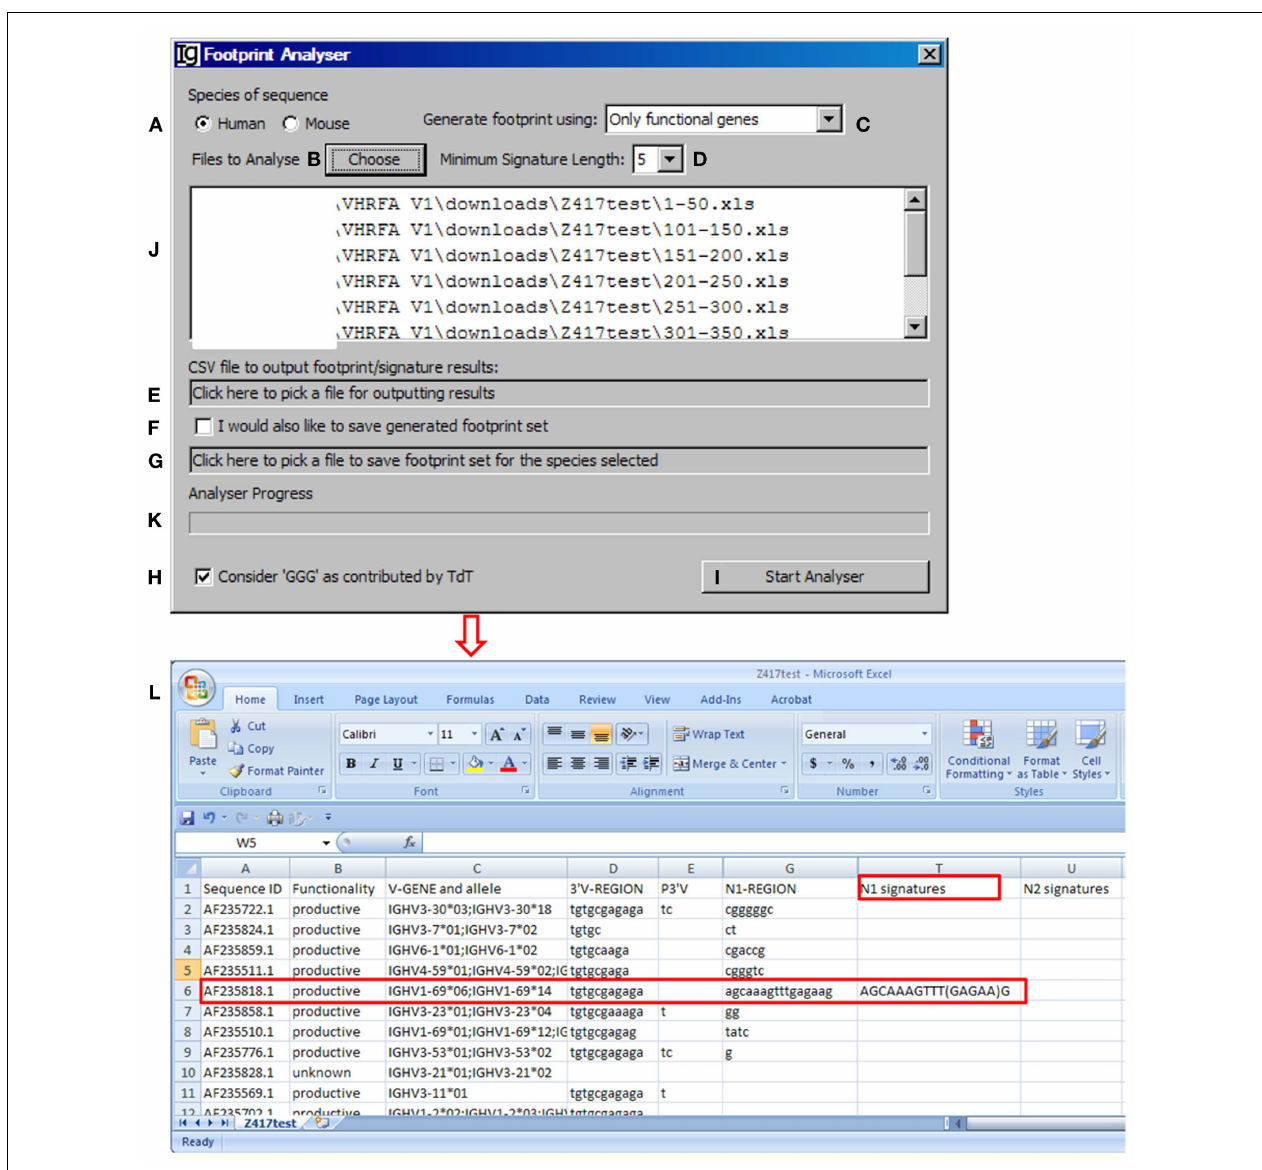
file (G) , exclude footprints with “GGG” sequence (H) , start the analysis (I) .The selected files for analysis will be shown in the window (J) (The Z417 test sequences), and analysis progress will be shown in a progress bar (K) .The footprint analyses results will be saved in Excel format (L) .The identified sequence with 5-mer footprint in the N1 region is highlighted in the red box.The identified footprint (GAGAA) in the N1 region is listed in ColumnT (N1